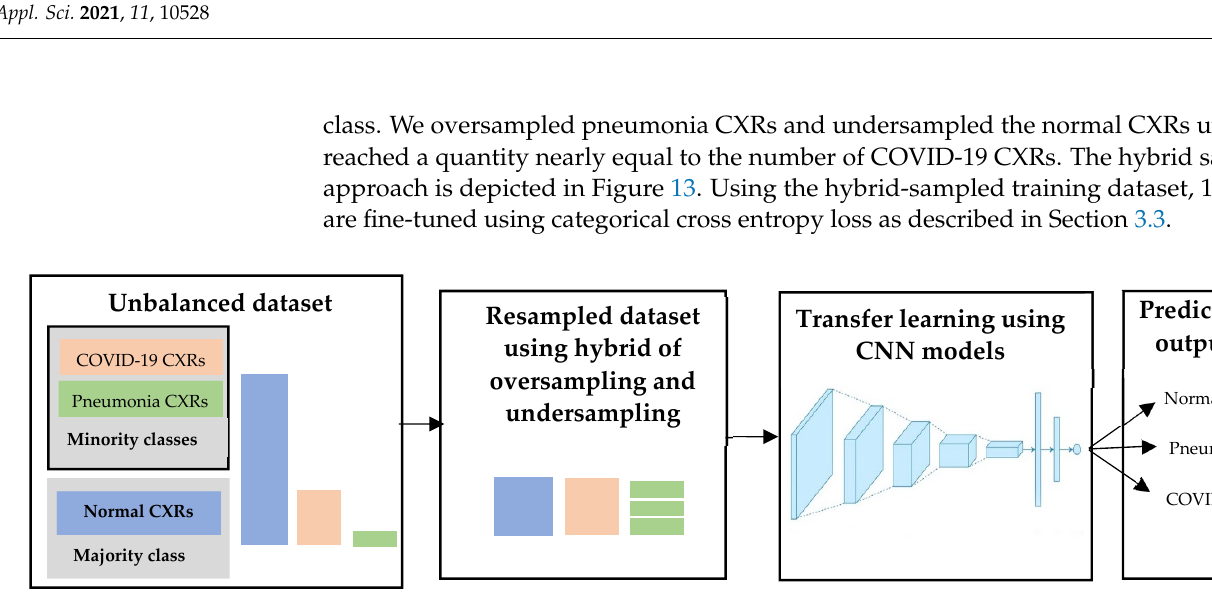
Figure 13. Deep learning with hybrid resampling on an unbalanced dataset.